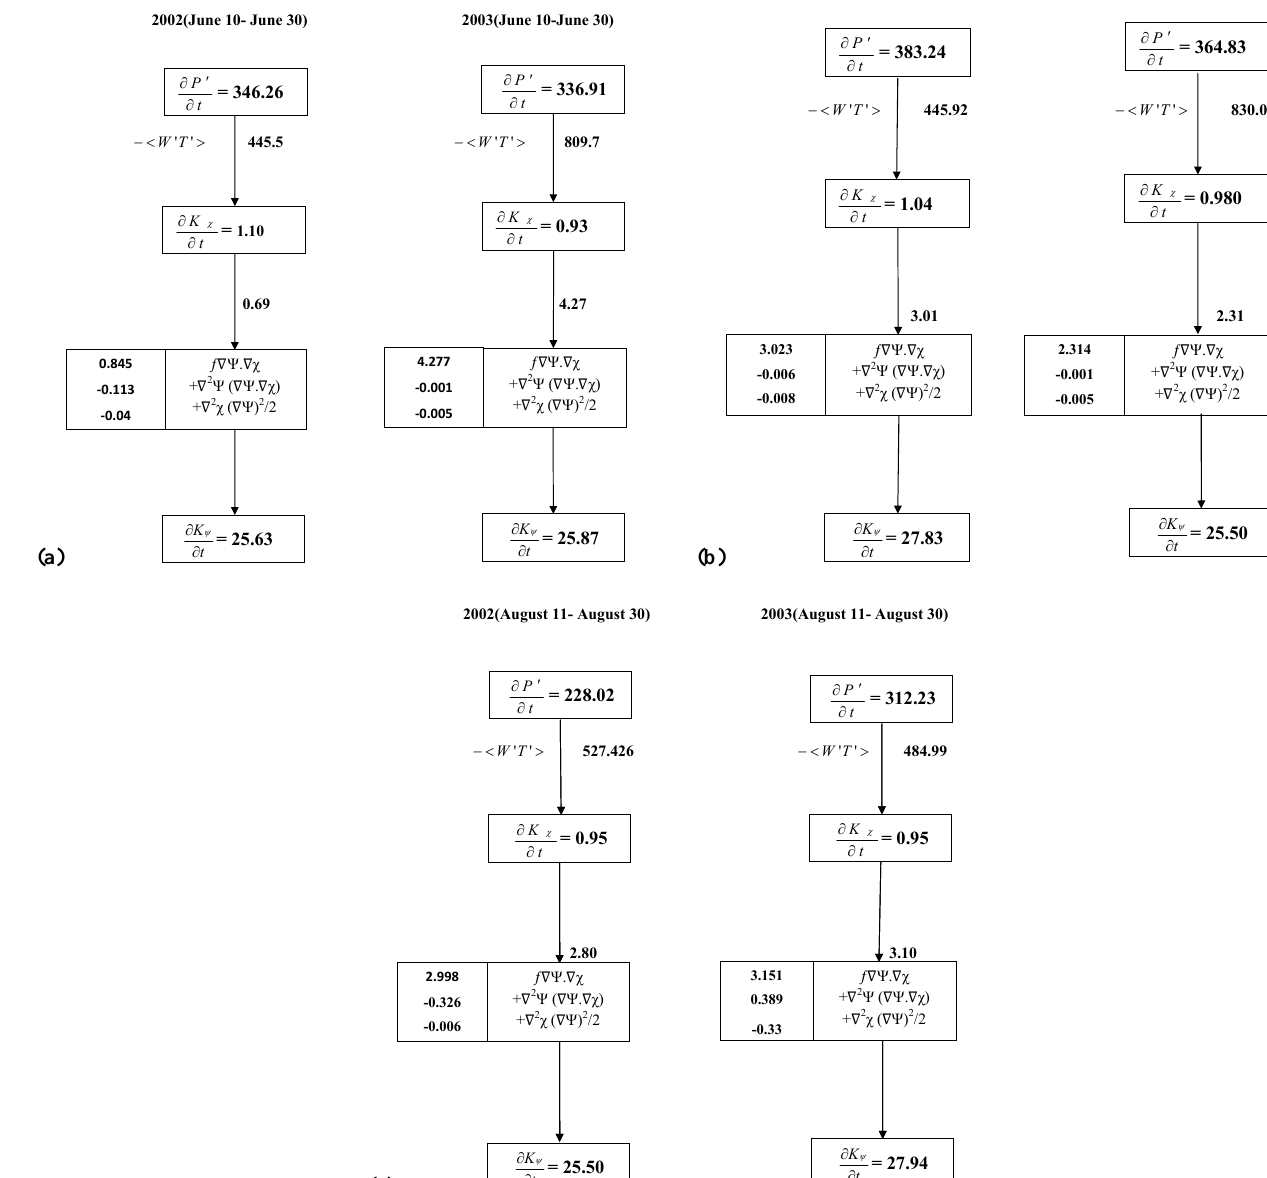
Fig. 10. Different energy exchanges are shown in the boxes and their time rates of change in units is m 2 s − 3 . These are the mean values over the domain 30 ◦ S–40 ◦ N, 30 ◦ E–150 ◦ E and 1000hPa to 100hPa for the before break, break, after break shown in panels (a) , (b) , (c) , respectively.